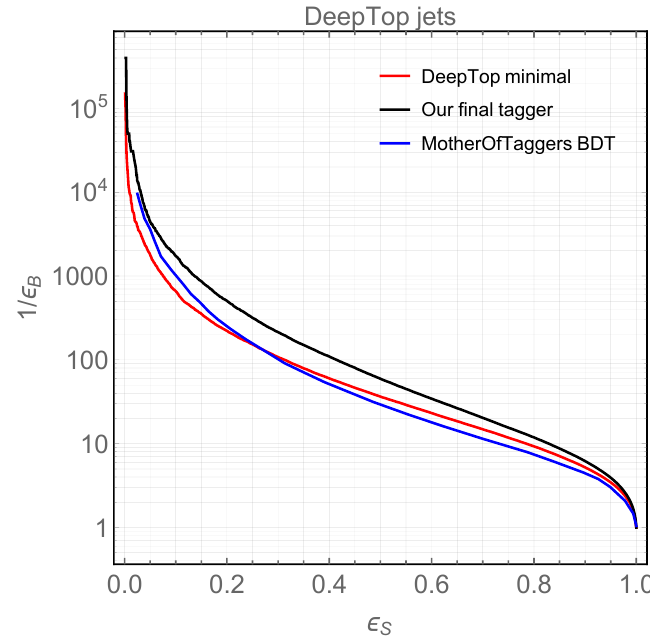
Figure 7 . ROC curves comparing our best top tagger (black), the original DeepTop tagger (red), and the \MotherOfTaggers" BDT built out of high-level inputs from [39] (blue solid), for the DeepTop jet